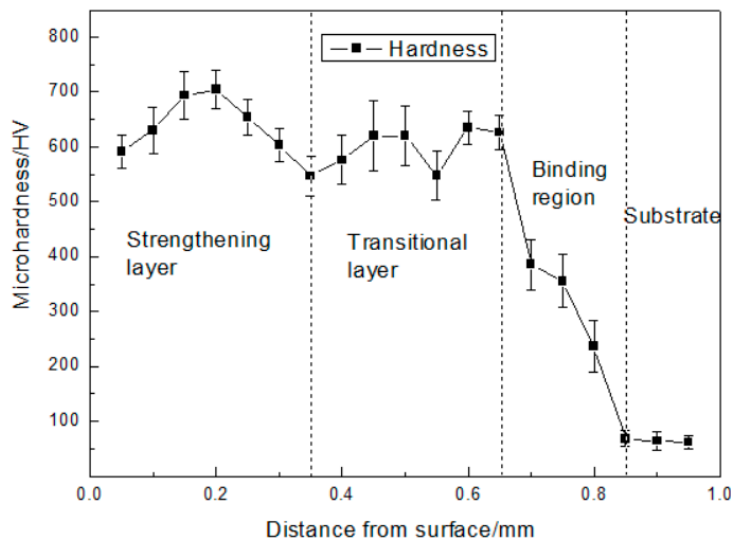
Figure 6. Microhardness variation of the cladding coating’s cross-section.